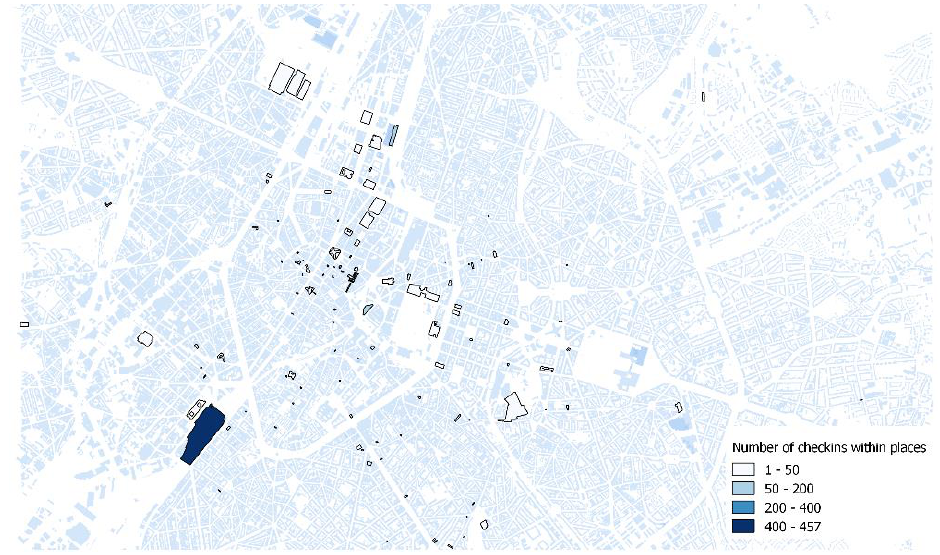
Figure 9. The number of check-ins effected in each location. The locations in which there are more check-ins include stations, hotels, tourist haunts and famous buildings. check-ins include stations, hotels, tourist haunts and famous